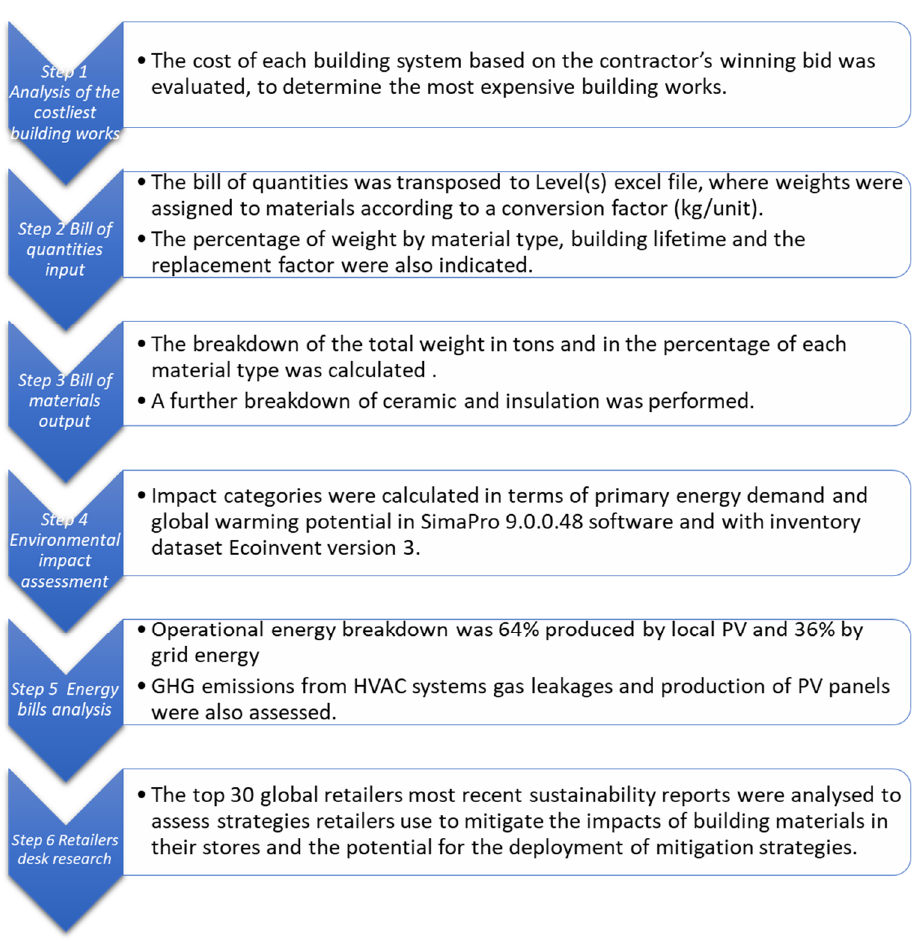
Figure 5. Methodology flow chart.